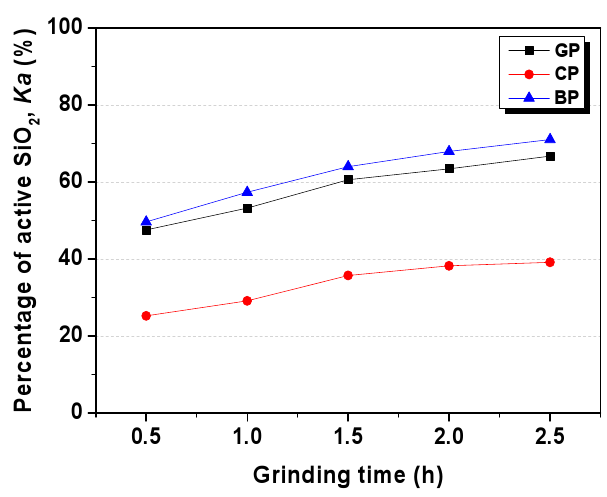
Figure 2. SiO 2 activity rate of waste glass powder. GP, green glass powder; CP, colorless glass powder; BP, brown glass powder.